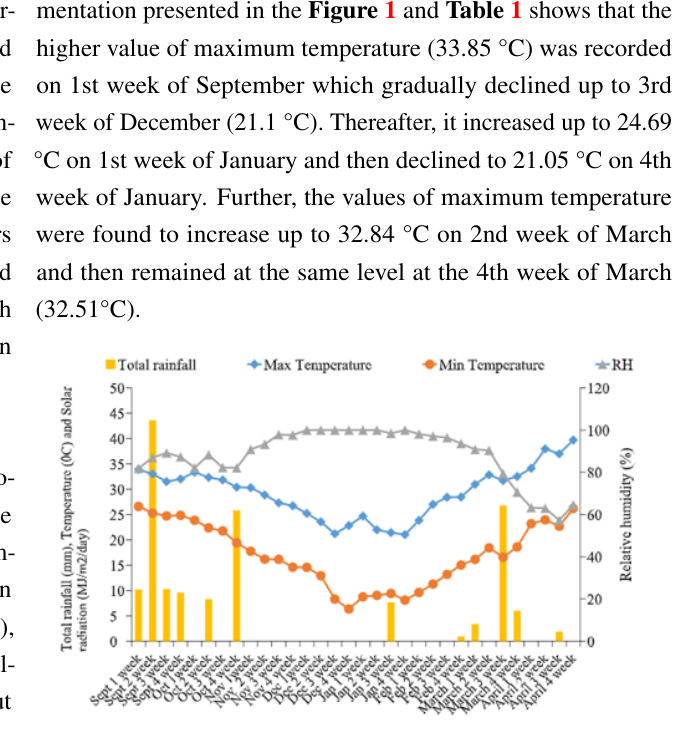
Figure 1. Weather condition during the course of experimentation at NMRP, Rampur, Chitwan, Nepal, 2015 / 16. On the other hand, the minimum temperature was found to decrease from first week of September (26.60 °C) to 4th week of December (6.36 °C) and then remained almost at the same level (8.16 to 9.64 °C) from 1st week of January to 1st week of February and thereafter increased to 18.43 °C on 2nd week of March. Further, similar minimum temperature (18.61 °C) was recorded on 4th week of March. In spite of it, the maximum rainfall of 43.6mm was recorded on 2nd week of September and thereafter it declined to zero precipitation on 1st week of October. However, a remarkable rainfall of 25.83mm was recorded on 4th week of October. Further, there was no rainfall from the 1st week of November to 3rd week of February with the exception of January 3rd week where there was a rainfall of 7.7 mm. The relative humidity was found to increase from 1st week (81.86%) to 3rd week (89.14%) and then declined on 4th weeks (87.33%) of September. Similarly, it increased from 1st (82.14%) to 2nd (88.29%) and then remained at the same level in 3rd (82.29%) and 4th (82.10%) weeks of October. Further, the values of relative humidity were increasing from 90.86% on 1st week of November to 100% on 1st week of December and thereafter remained at this level up to 4th week of January with exception of 3rd week of January where it was a little decreased (98.43%). Thereafter,